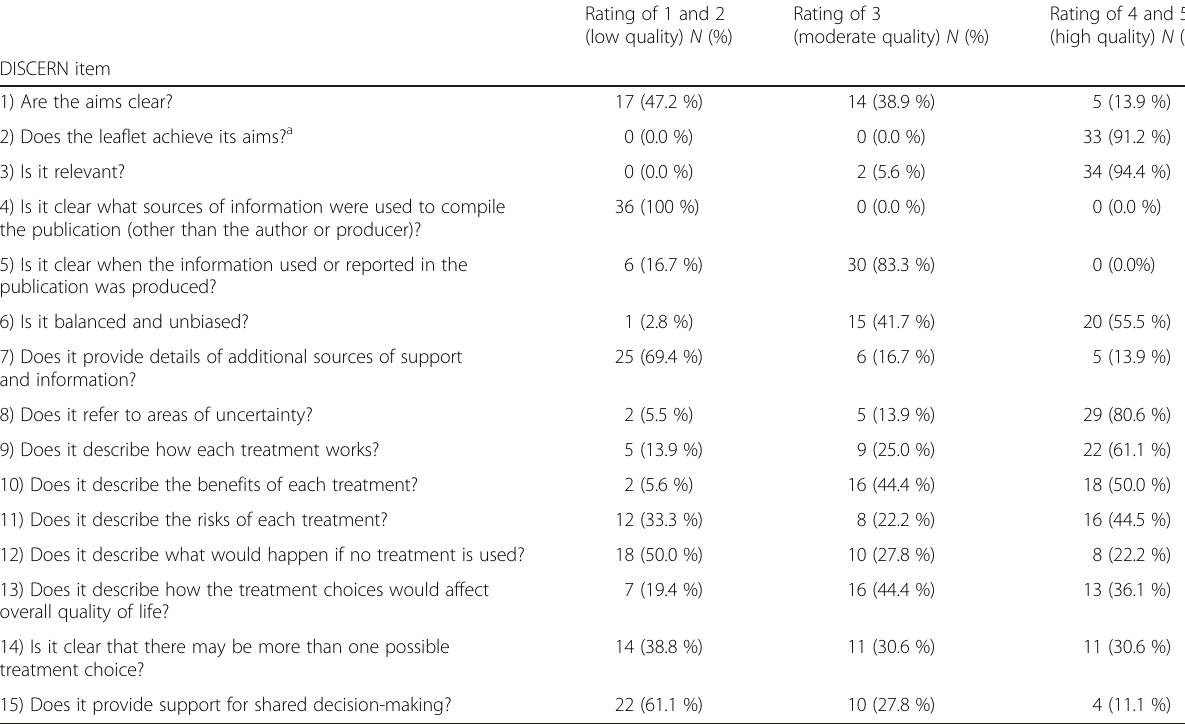
Table 1 The ratings of individual DISCERN items ( N = 36)